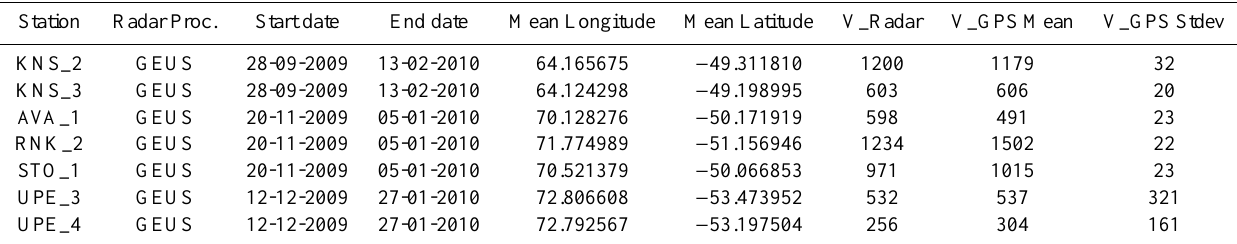
Table 2. Comparison of ice velocities derived by GEUS from ALOS / PALSAR satellite radar imagery and ice velocities from GPS measure- ments. Start and end dates refer to the time window between image acquisitions. Ice velocities are given in myr − 1 , latitudes and longitudes in decimal degrees N and W, respectively, using the World Geodetic System 1984 (WGS84). Station Radar Proc.